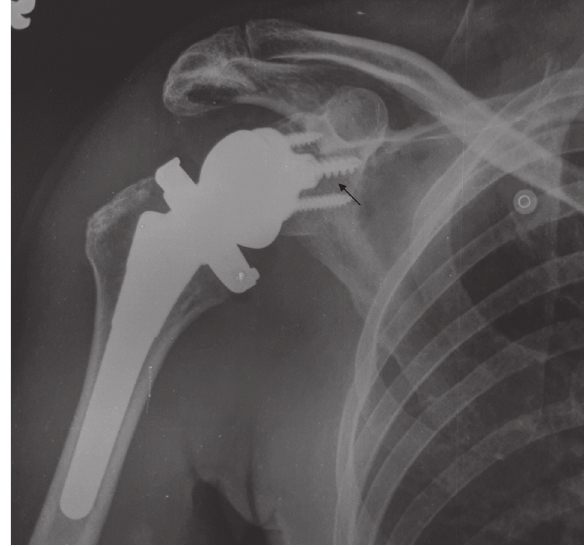
Anterior-posterior view of a shoulder radiograph Fig. 1: showing narrowed acromio-humeral interval (arrow), which is superior migration of the humeral head indicating rotator cuff arthropathy. Intra-operatively, the rotator cuff was found irreparably destroyed.